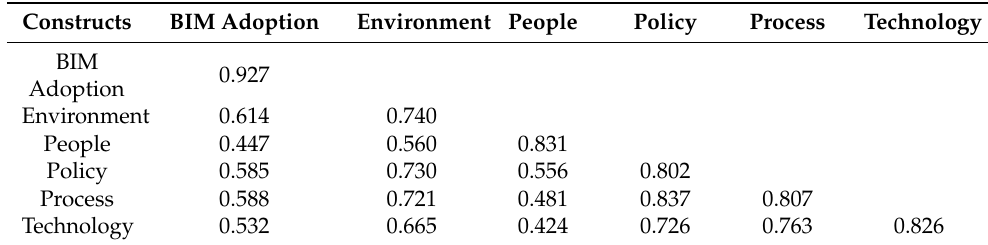
Table 6. Discriminant Validity—Fornell and Lacker Criterion.